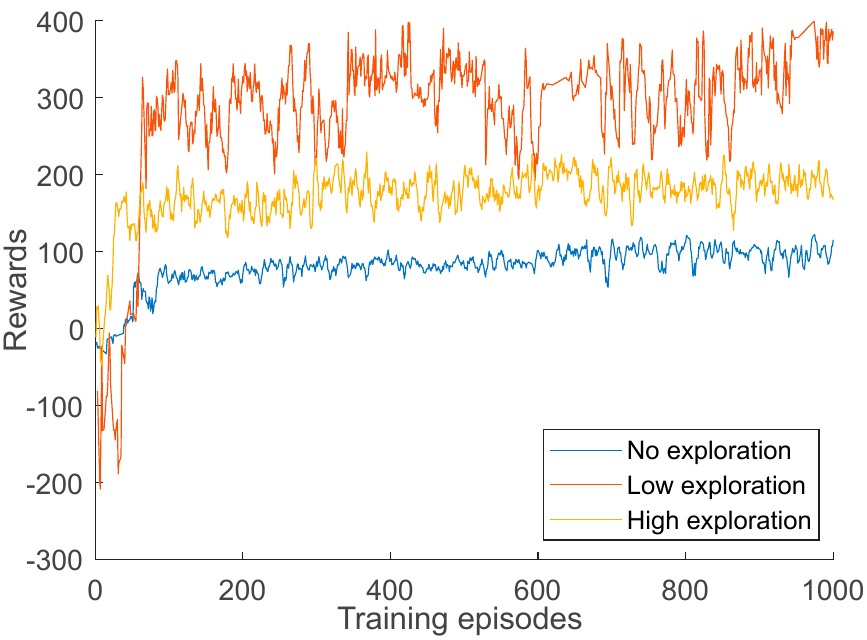
Figure 8. Reward function for different exploration rates .